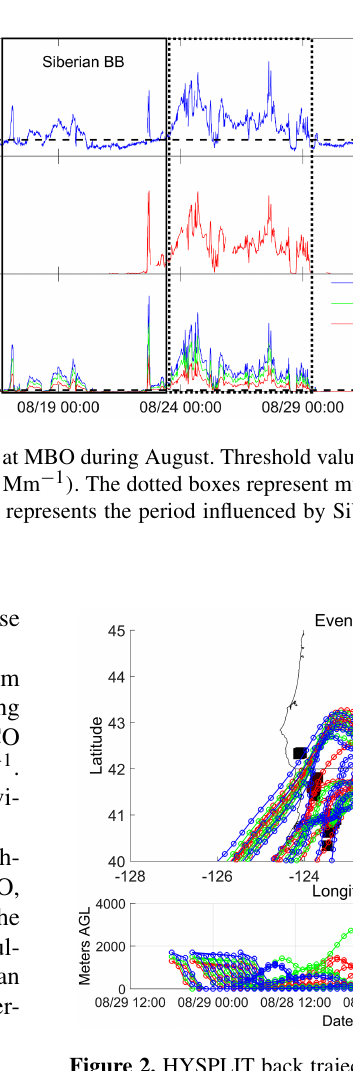
Figure 2. HYSPLIT back trajectories for Event 19. The blue back trajectories have a starting height of 1700ma.m.g.l. (above model ground level), the green a starting height of 1500ma.m.g.l., and the red a starting height of 1300ma.m.g.l. The squares are MODIS fire spots from 27 to 29 August 2015 and are colored based on their fire radiative power